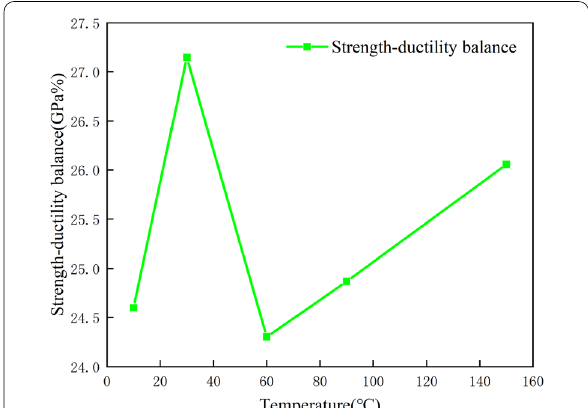
Figure 16 Tensile strength and elongation with different tempering times Figure 17 Strength and ductility with different tempering